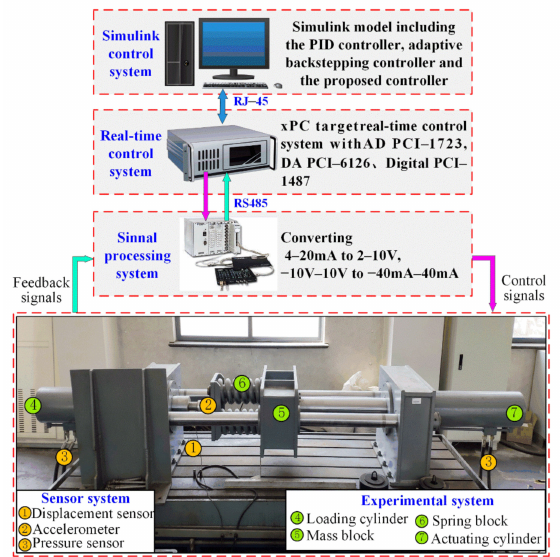
Figure 5. Electro-hydraulic servo displacement control experimental system. PID, proportion integral